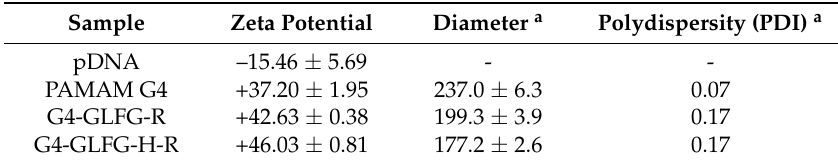
Figure 5. Zeta potential graph of polyplexes. Table 1. Zeta potential and mean diameter values of polyplexes.